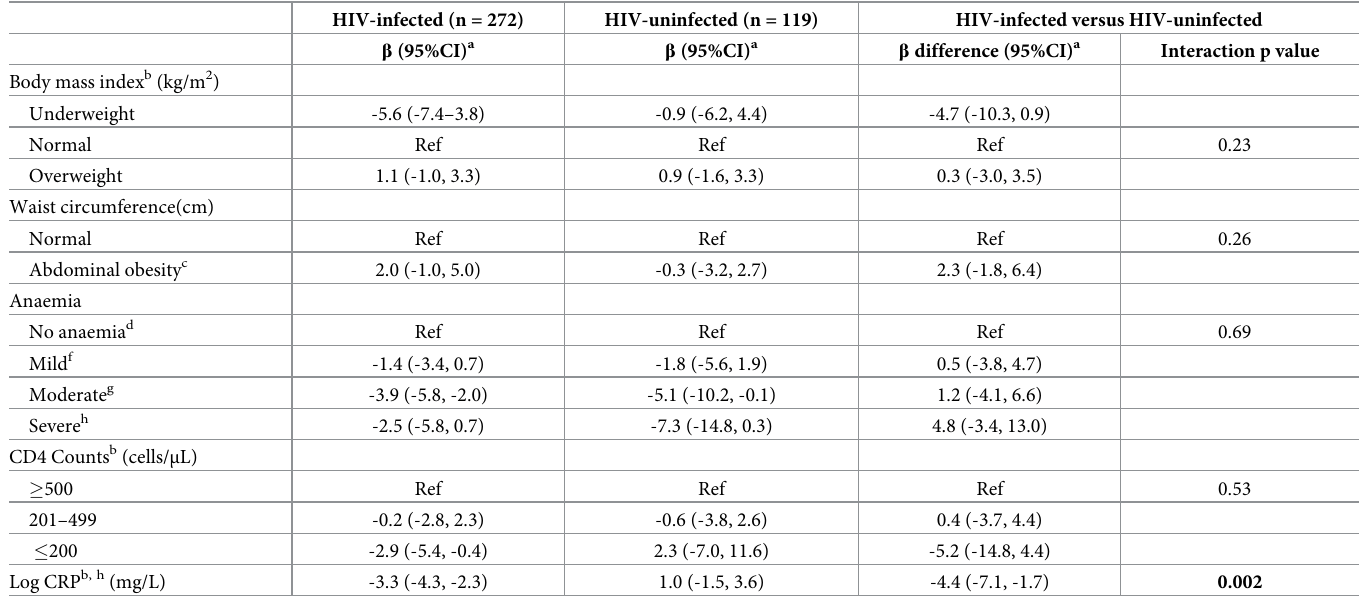
Table 4. Correlates of grip strength (kg) among HIV-infected and HIV-uninfected